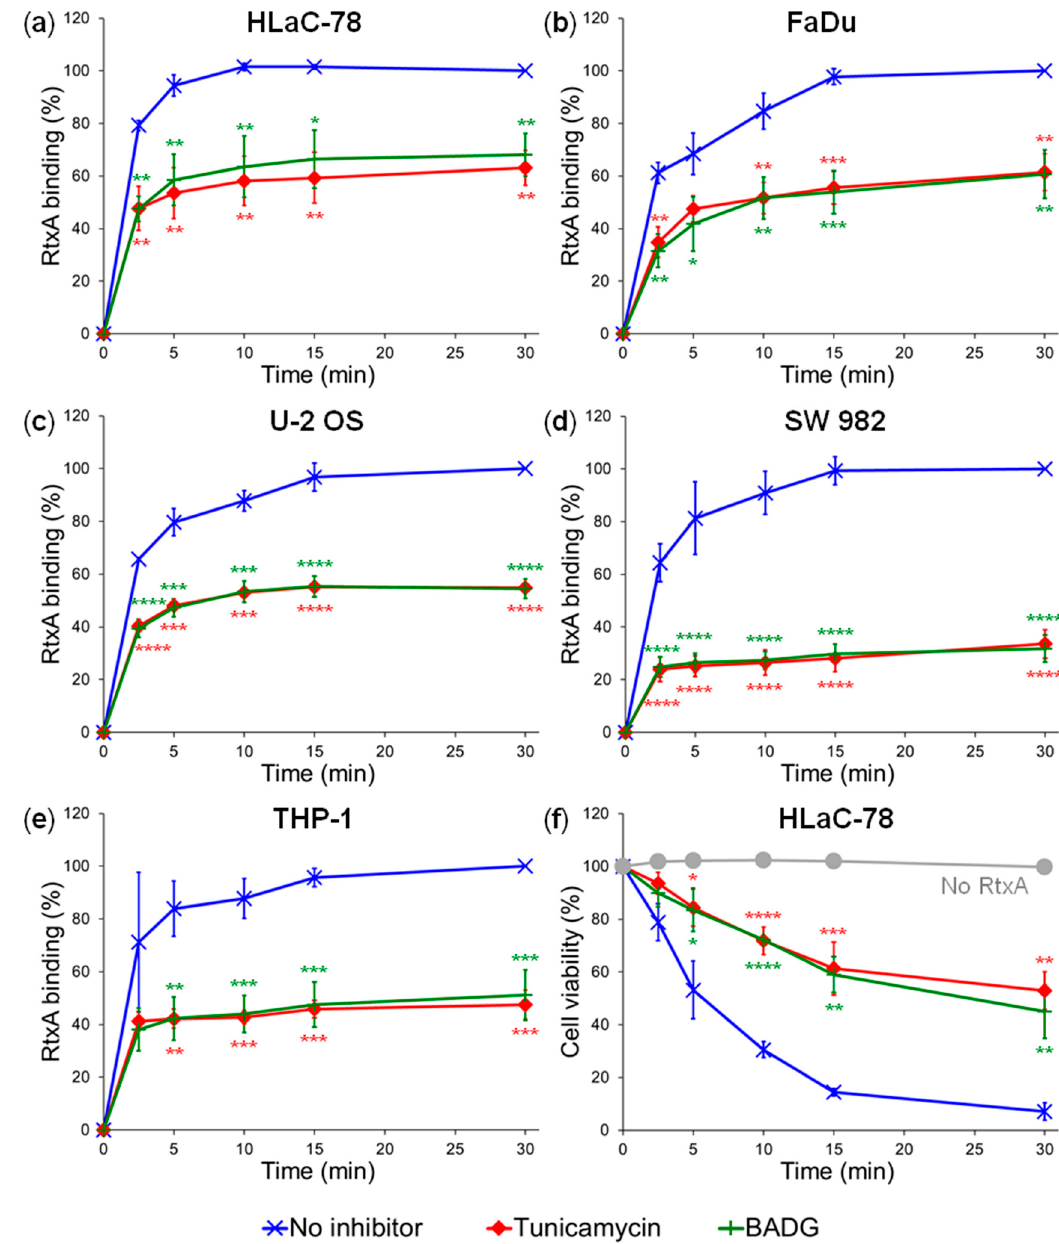
Figure 3. Treatment of cells with different inhibitors of glycosylation decreases binding and cytotoxic activity of RtxA. Human HLaC-78 ( a ), FaDu ( b ), U-2 OS ( c ), SW 982 ( d ), and THP-1 ( e ) cells were treated with tunicamycin, benzyl-2-acetamido-2-deoxy- α -D-galactopyranoside (BADG) or buffer alone (no inhibitor) for 24 h at 37 °C. Then, the cells (1 × 10 6 /mL) were incubated with 2 µg/mL of the purified and labeled RtxA-Dy495 toxin for different times at 4 °C, and the surface-bound RtxA-Dy495 was determined by flow cytometry. Binding data were deduced from the MFI values and expressed as percentage of RtxA binding to untreated cells at time 30 min (taken as 100%). Each point represents the mean value ± SD of three independent experiments. Significant differences between mean values of RtxA binding to inhibitor-untreated cells and cells treated with inhibitors are indicated (*, p < 0.05; **, p < 0.01; ***, p < 0.001; ****, p < 0.0001; ANOVA). ( f ) Inhibitor-treated and untreated HLaC-78 cells (1 × 10 6 /mL) were incubated with 0.5 µg/mL of the purified RtxA toxin for different times at 37 °C. Cell viability was determined by a cell viability staining assay using 1 µg/mL of Hoechst 33258 followed by flow cytometry. The viability of cells incubated without RtxA (time 0) was reported as 100%. Each point represents the mean value ± SD of three independent experiments. Significant differences between mean values of cell viability of inhibitor-treated and inhibitor-untreated cells upon incubation with RtxA are indicated (*, p < 0.05; **, p < 0.01; ***, p < 0.001; ****, p < 0.0001; ANOVA).